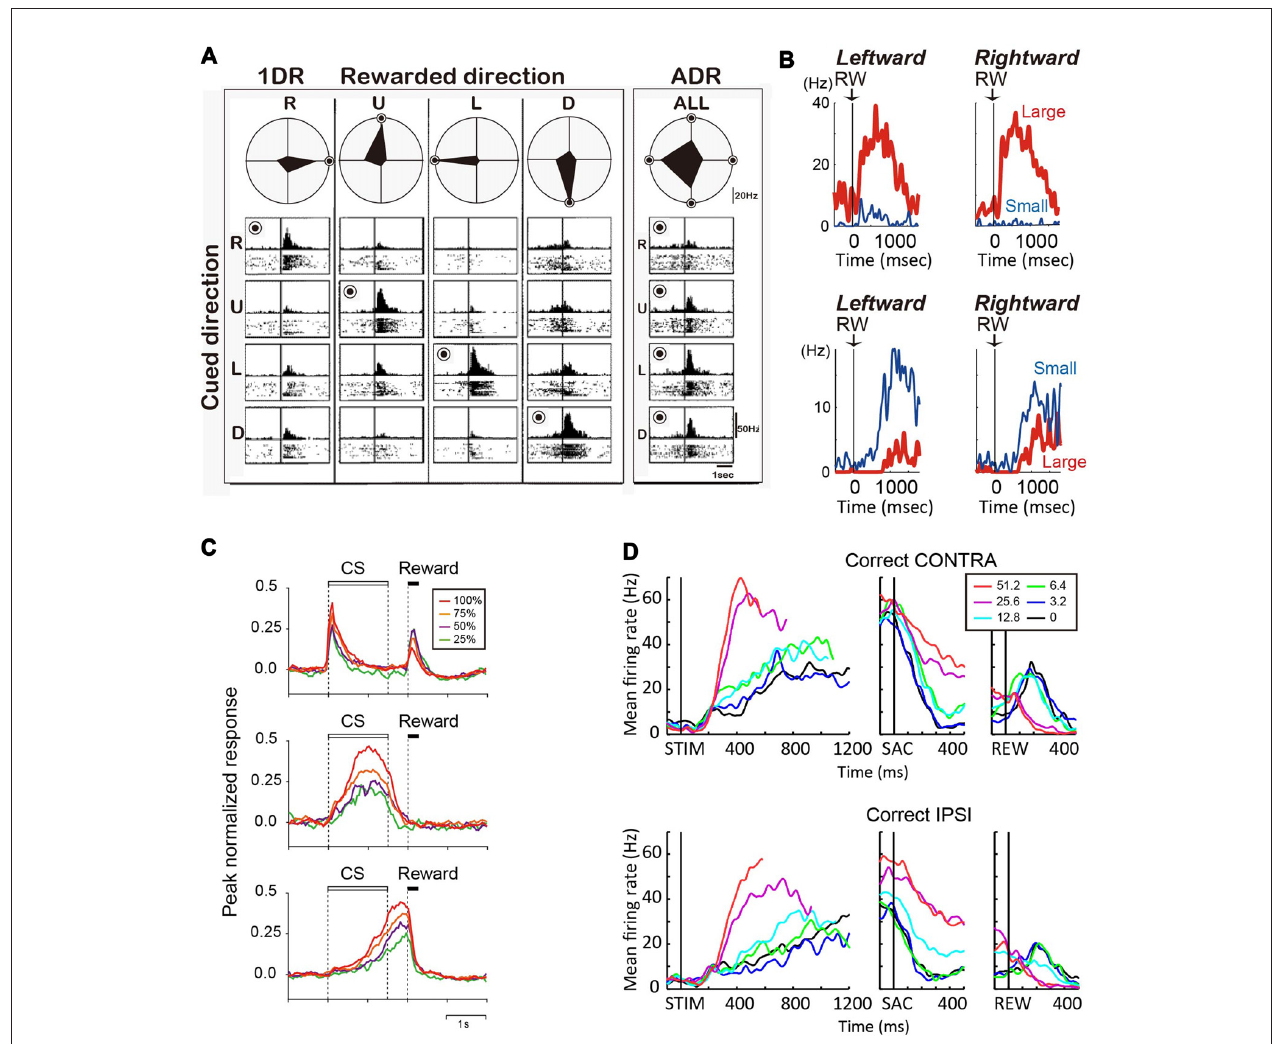
FIGURE 2 | (A) Reward-dependent visual response of a right caudate neuron. The data obtained in one block of all-direction rewarded (ADR condition, right) and four blocks of one-direction rewarded (1DR condition, left) are shown in columns. The histograms and rasters are aligned on cue onset for different cue directions (R, right; U, up; L, left; D, down). The rewarded direction is indicated by a “bull’s eye mark”. Polar diagrams show the magnitudes of response for four cue directions. The neuron’s response was strongest for the rewarded direction in any block of 1DR, whereas its preferred direction was to the left in ADR (modified from Kawagoe et al., 1998). (B) Top, an example of central caudate neuronal activity showing a positive reward effect in the biased-reward saccade task ( Figure 1A ). Bottom, an example dorsal caudate neuron showing a “negative” reward effect. (C) Average activity of three types of neurons in the dorsal striatum of rats participating in a probabilistic Pavlovian conditioning task, in which auditory conditioned stimuli (CS) indicate reward probability. Top, CS phasic neurons; middle, CS tonic neurons; bottom, US build-up neurons. (D) An example neuron showing similar coherence modulation for both contra- and ipsi-lateral choices. Note the positive coherence modulation during dots viewing (STIM) and around saccade onset (SAC), and negative coherence modulation after reward onset